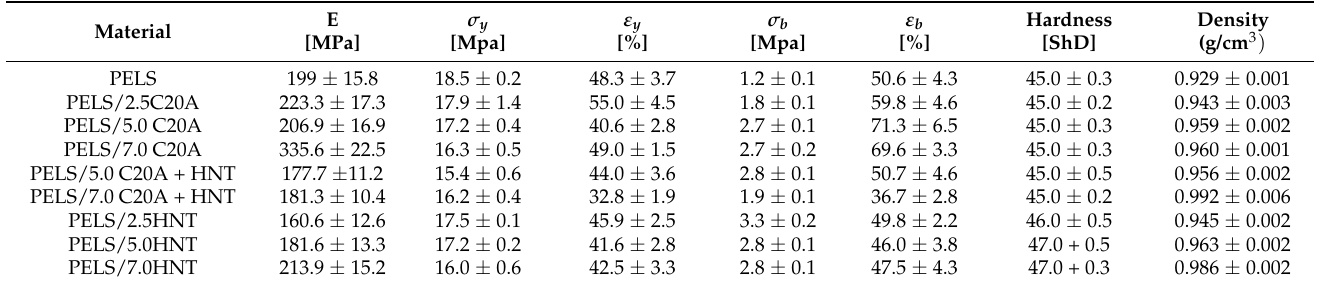
Figure 8. XRD patterns for the series of nanocomposites based on PELC: ( a ) in reference to C20A; ( b ) in reference to HNT. Table 3. Mechanical properties for PELS-based nanocomposites.